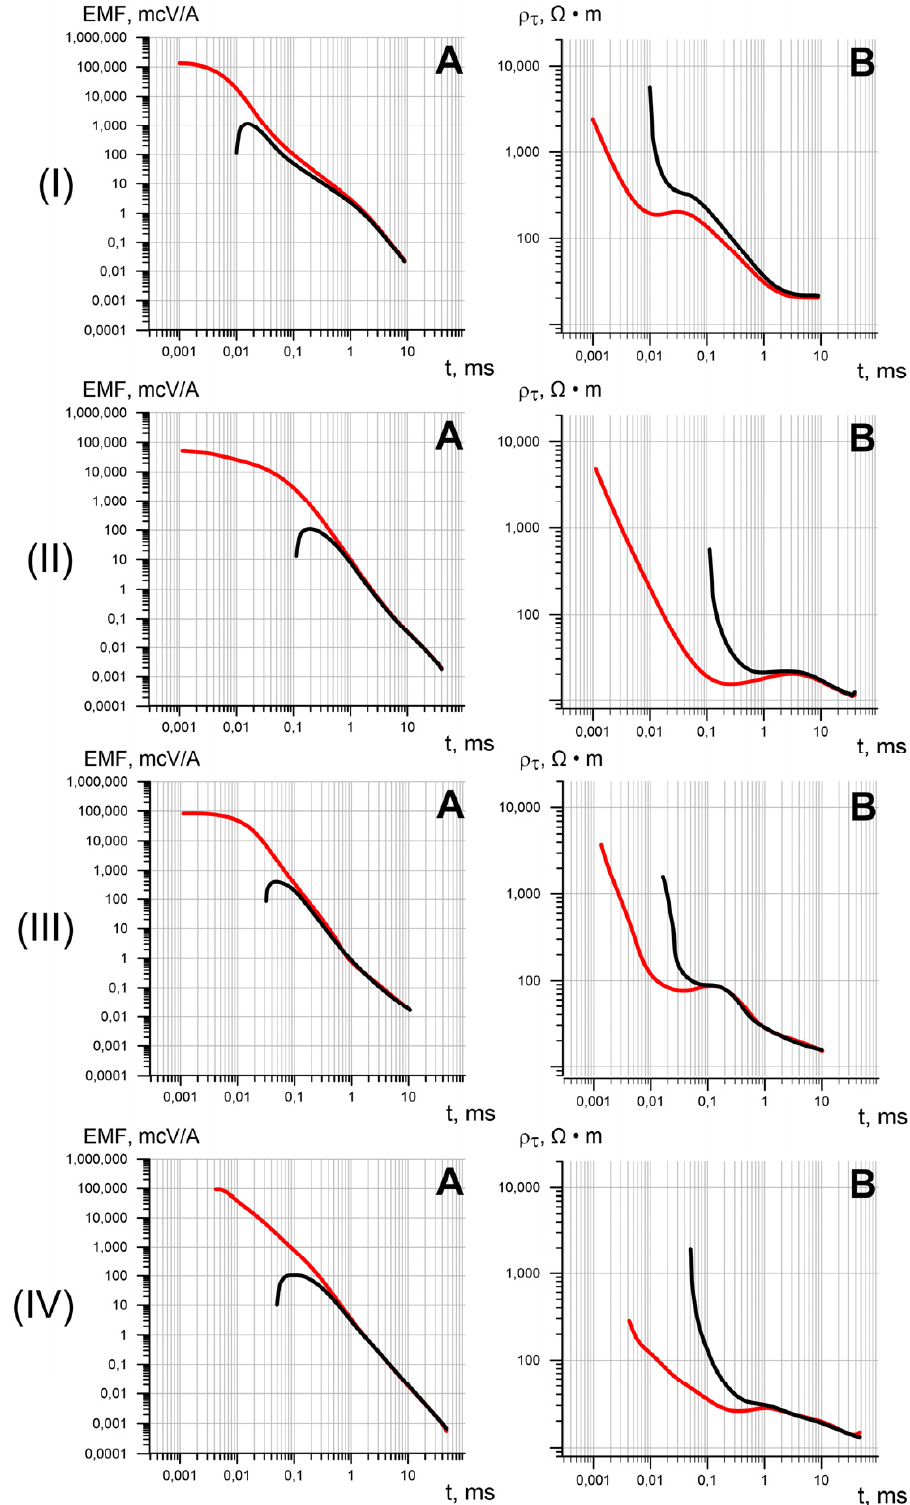
Figure 7. sTEM curves free from IP effects collected in the Urengoi ( I ), northern Yamal ( II ), Nadym ( III ), and southern Ob Gulf ( IV ) areas, with central–loop (black) and loop–loop (red) arrays, at an offset of 100 m. Panels ( A , B ) show, respectively, time-dependent voltage decay and apparent resistivity.